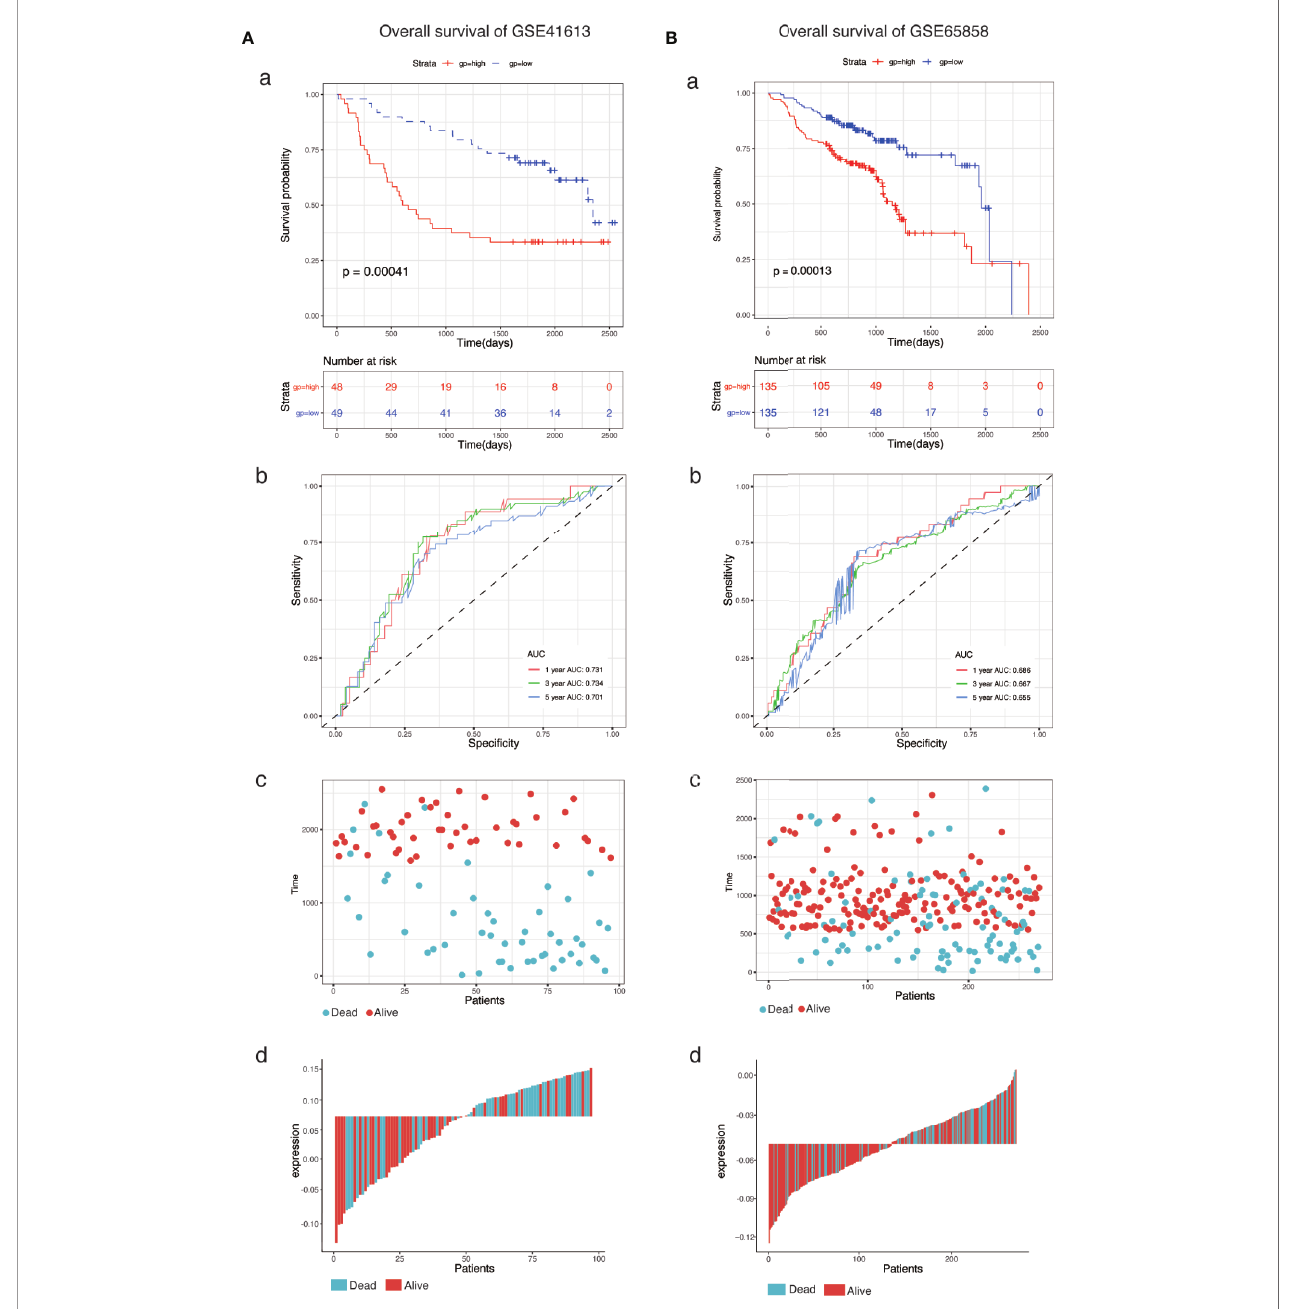
FIGURE 3 | KM survival, risk score by eight-gene signature and time-dependent ROC curves in the OS validation datasets. (A) GSE41613, (B) GSE65858. (a) KM survival analysis between high- and low-risk samples. (b) Time-dependent ROC curve for overall survival of validation datasets, the AUC was assessed at 1, 3, and 5-years. (c) Relationship between survival time (day) and risk score rank. (d) Relationship between survival status and risk score